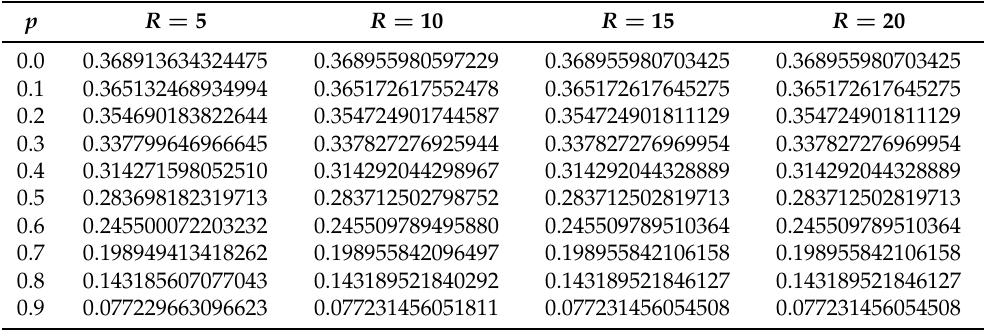
Table 5. A comparison of numerical outcomes/REFs in QLM-GSAPSK with θ = 1.9, λ =